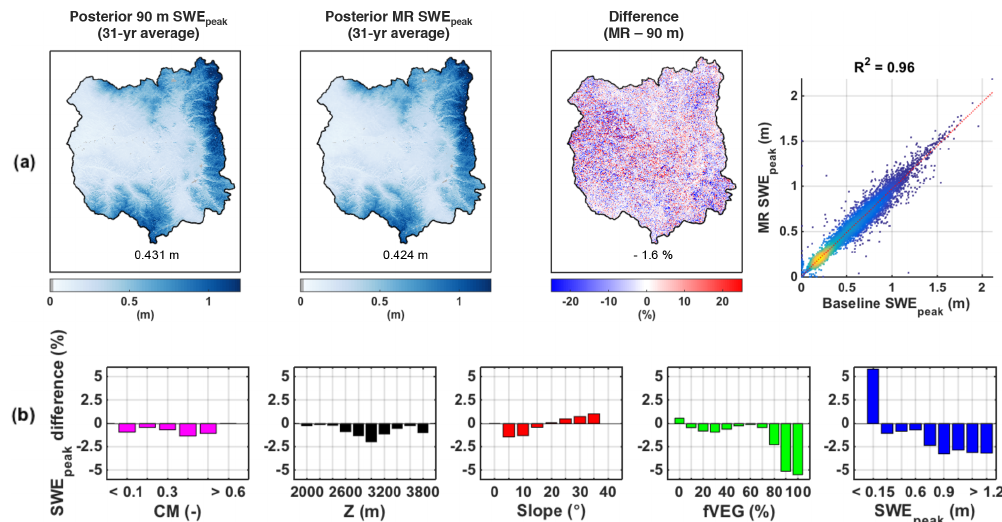
Figure 6. (a) Maps of pixel-wise 31-year-average posterior peak SWE (SWE peak ) over the upper Yampa River basin for the 90m baseline, the MR case, the percentage difference between the two approaches (MR − baseline), and the corresponding scatter plot. Basin averages are displayed at the bottom of each map. (b) Distribution of SWE peak relative difference with complexity metric (CM), elevation ( Z ), slope, forested fraction (fVEG), and SWE peak . Pixels with a 31-year-average SWE peak lower than 5cm were discarded from the analysis.